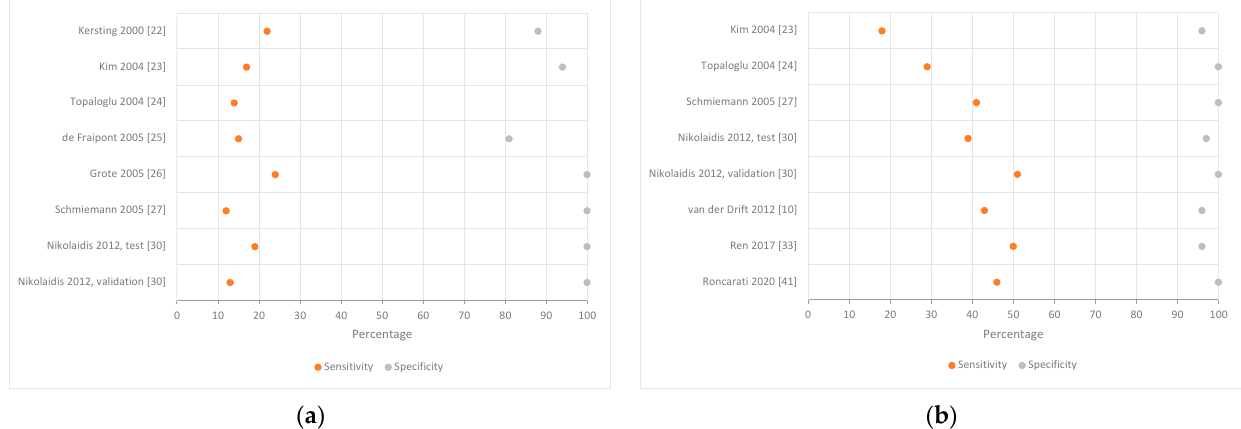
Figure 3. Forest plot illustrating the sensitivity (orange) and specificity (gray) of the most frequently investigated genes ( a ) p16(INK4A) and ( b ) RASSF1A. The x-axis represents study sensitivity and specificity in percent. There are no whiskers, since many studies did not report a 95% confidence interval.